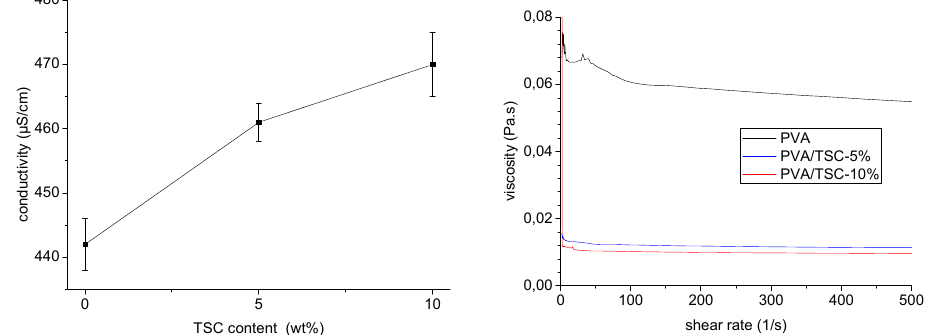
Figure 1. Conductivity ( left ) and viscosity ( right ) of PVA / TSC (0%, 5%, and 10%) polymer solutions in water–ethanol (9:1).